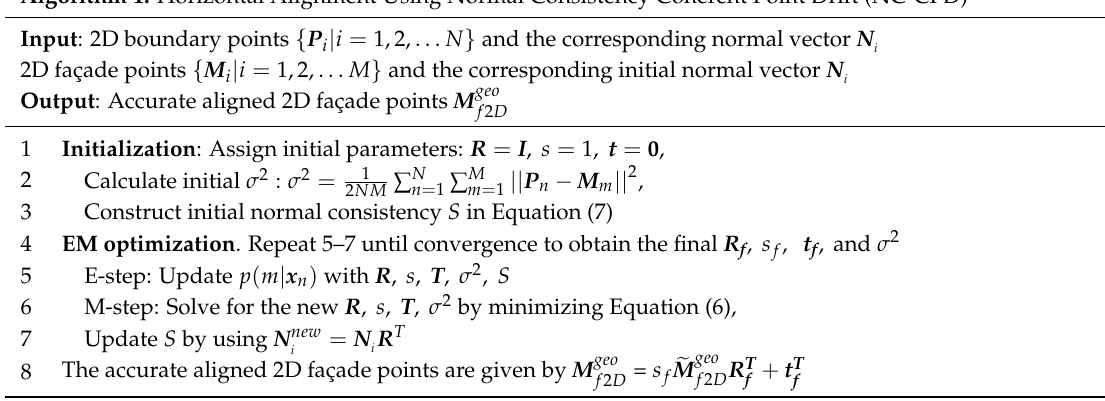
Algorithm 1: Horizontal Alignment Using Normal Consistency Coherent Point Drift (NC-CPD) Input : 2D boundary points { P i | i = 1,2, . . . N } and the corresponding normal vector N